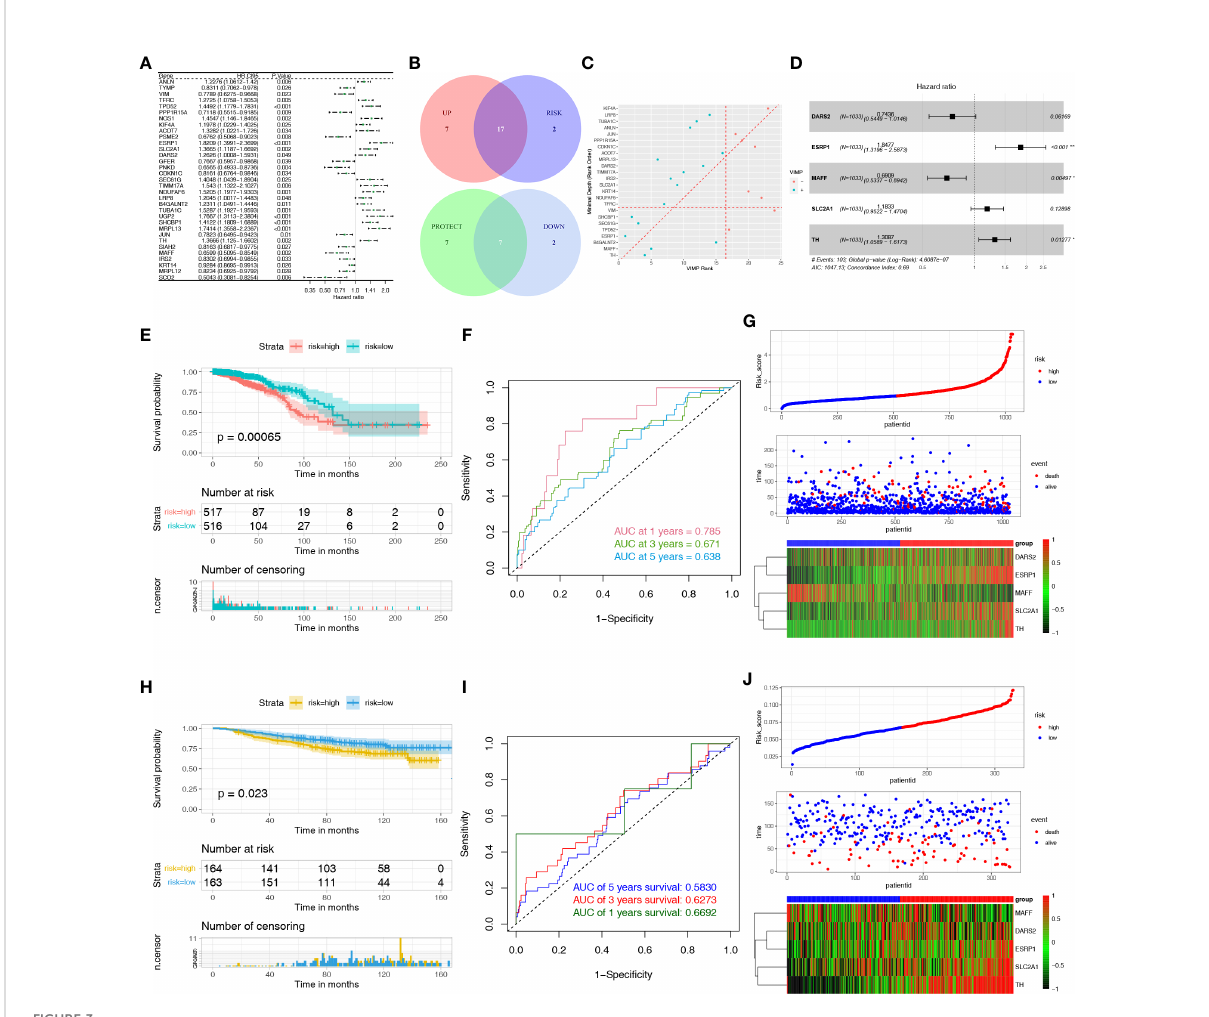
FIGURE 3 Construction and evaluation of the HLMRPM. (A) Univariate Cox regression analysis of the DEHRGs and DELMRGs in the training cohort. (B) The veen diagram indicated the favorable and unfavorable genes. (C) The genes were ranked by the minimal depth and VIMP. (D) The forest graph showed the results of stepwise multivariable cox proportional hazards regression analysis. (E) The OS curve of the two risk groups in TCGA cohort. (F) The time-dependent ROC curves of the HLMRPM in TCGA cohort. (G) The risk score, clinical event, and the model genes between the two risk groups in TCGA cohort. (H) The OS curve of the two risk groups in GSE20685 cohort. (I) The time-dependent ROC curves of the HLMRPM in GSE20685 cohort. (J) The risk score, clinical event, and the model genes between the two risk groups in GSE20685